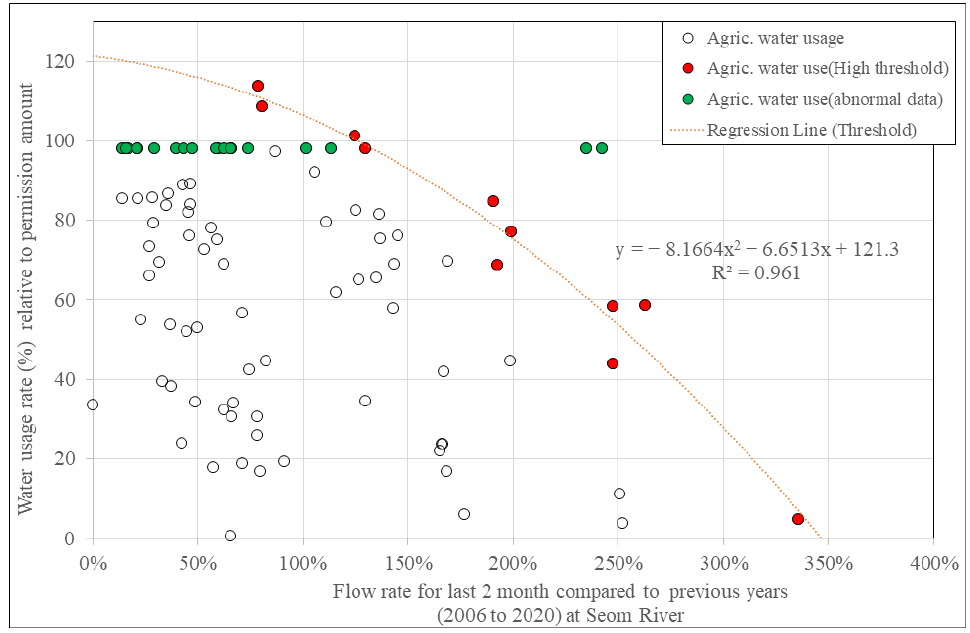
Figure 6. Scatter diagram of the percent of normal year runoff and the water usage rate compared to permission amount in the Seom River; red point indicates it has 0.95 or more value in CDF, red dot line is the threshold line of URP, and green point indicates data treated as abnormal records.